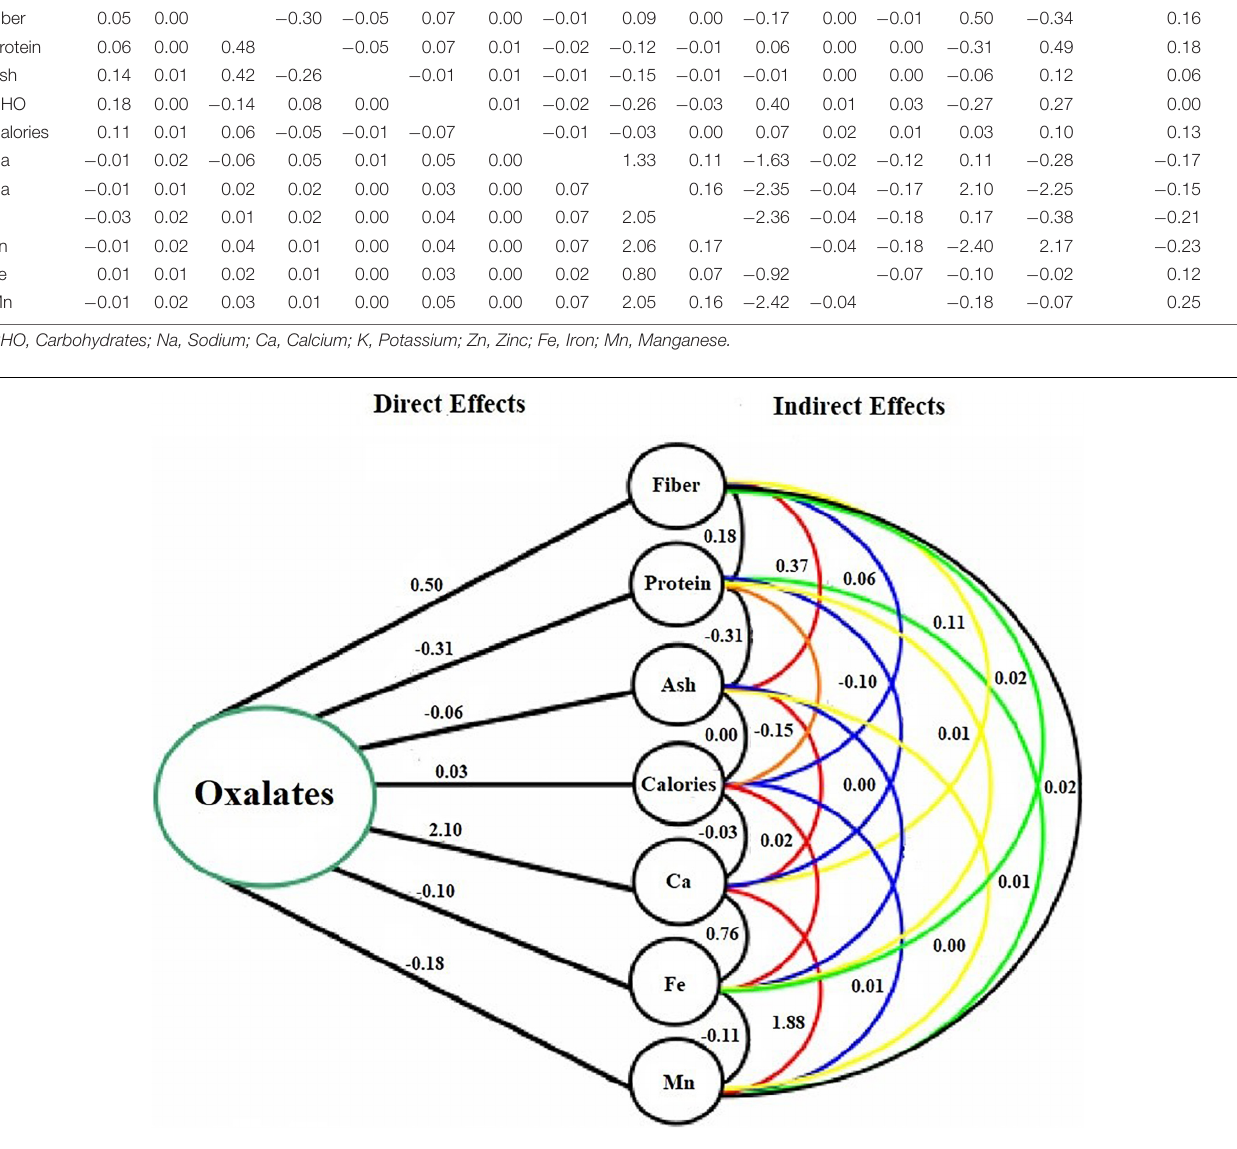
Table 1 ). Number of alleles ranged from 2 to 21.